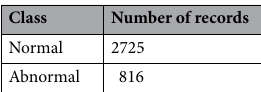
Table 2. The details of the second dataset.